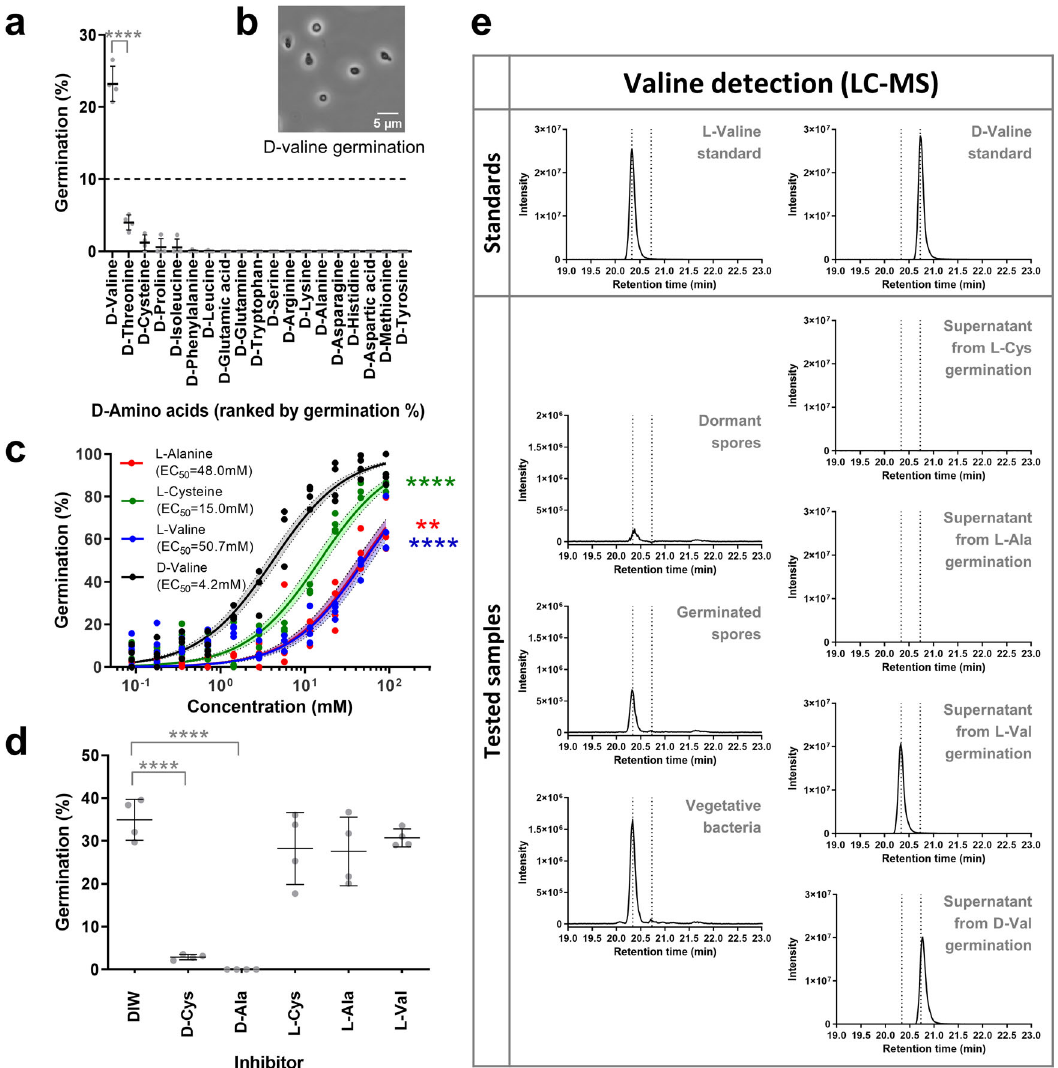
Fig. 5 D-valine is a bona fi de germinant. a Single factor screen for 19 D-amino acids where each D-amino acid was tested individually for germination at concentrations in Supplementary Table 3. Dashed line represents a germination threshold of 10%. D-amino acids are sorted in decreasing order of germination % from left to right. Signi fi cant at **** p ≤ 0.0001 (unpaired t-test) when compared with D-threonine. b Phase contrast image of C. novyi -NT spores germinated with D-valine (45.7 mM) at 1000× magni fi cation. Scale bar 5 µ m. c Dose response curve for germination response at different concentrations of D-valine (black), L-cysteine (green), L-alanine (red), and L-valine (blue) normalized to germination with D-valine at the highest concentration 91.5 mM. Circles depict individual values. Solid lines depict the least squares fi t regression curve. Shaded area shows the 95% con fi dence error bands for each L-amino acid fi t. EC 50 values are shown in the legend and are signi fi cant at **** p ≤ 0.0001,*** p ≤ 0.001,** p ≤ 0.01 (unpaired t-test) when compared to D-valine. d Germination by D-valine (91.5 mM) in the presence of other D- and L-amino acids (91.5mM). Signi fi cant at **** p ≤ 0.0001 (unpaired t-test) when compared with DIW control. e LC-MS EIC spectra of derivatized valine ion (379 m/z) for Standards of L-valine, D-valine, and Samples of Peptidoglycan extracts of dormant spores, germinated spores, vegetative bacteria and supernatants from spores germinated in L-cysteine, L- alanine, L-valine or D-valine. Data shown is the best representative of water blank-subtracted spectra from two independent experiments. Dotted lines represent the standard peaks for L-valine (20.34 min) and D-valine (20.73 min) respectively. All germination data depict mean ± SD, n = 4 biologically independent samples. Germination % for all graphs are de fi ned in Supplementary Table